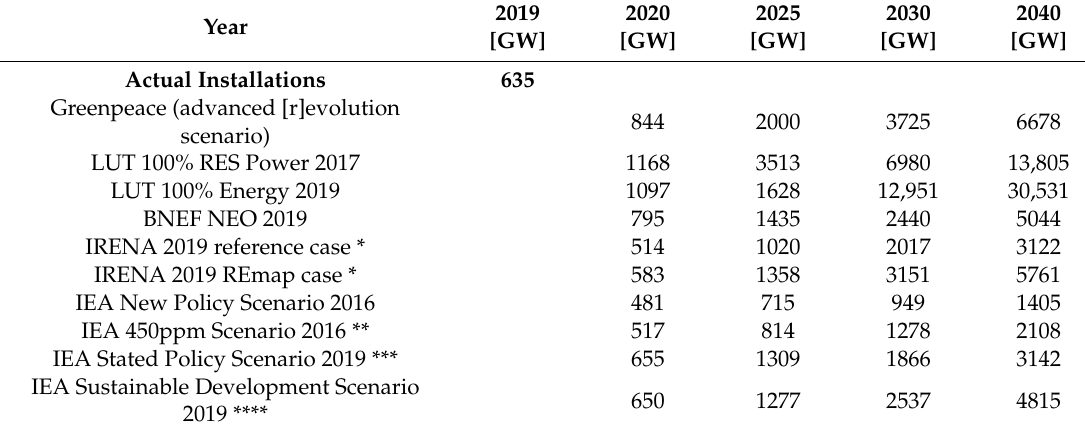
Table 1. Worldwide scenarios of cumulative solar photovoltaic electrical capacities until